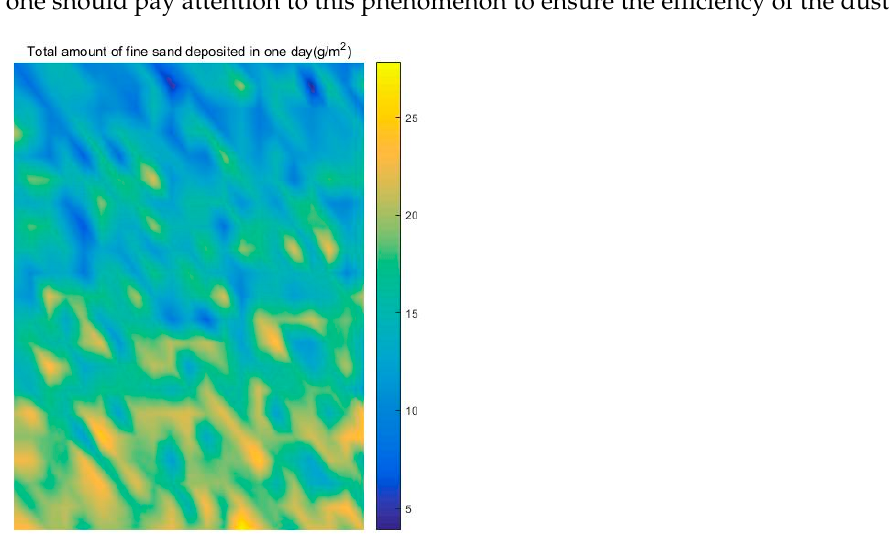
Figure 13. Cloud chart of particles deposited on solar panel in a day with a particle size of 100 um when u ∗ = 0.40 m/s and K = 3.5 × 10 6 Jm − 3 .